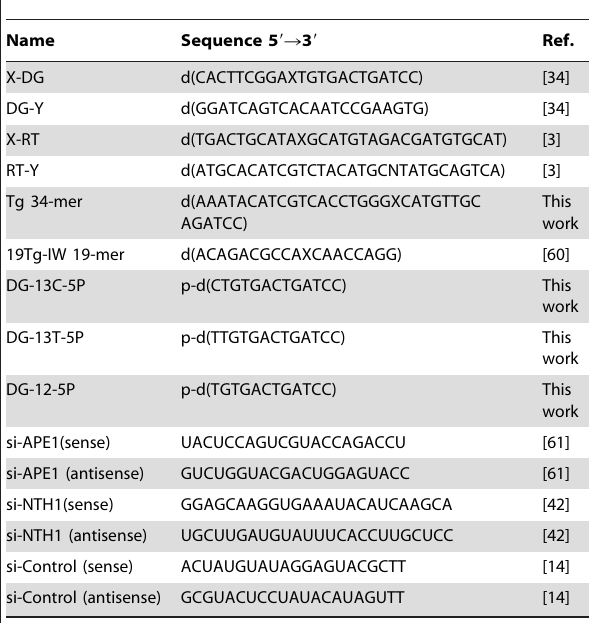
Table 2. Sequence of the oligonucleotides used in the study, where X is a corresponding modified residue: 5OH-Hyd, 5OH- 5Me-Hyd, DHU or